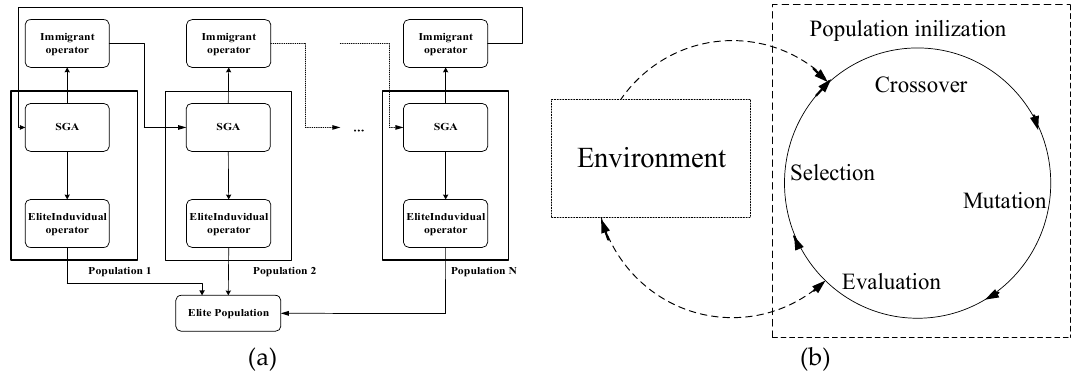
Figure 8. ( a ) The flow chart of multiple genetic algorithm; ( b ) The updated scheme of the Single Genetic Algorithm (SGA).